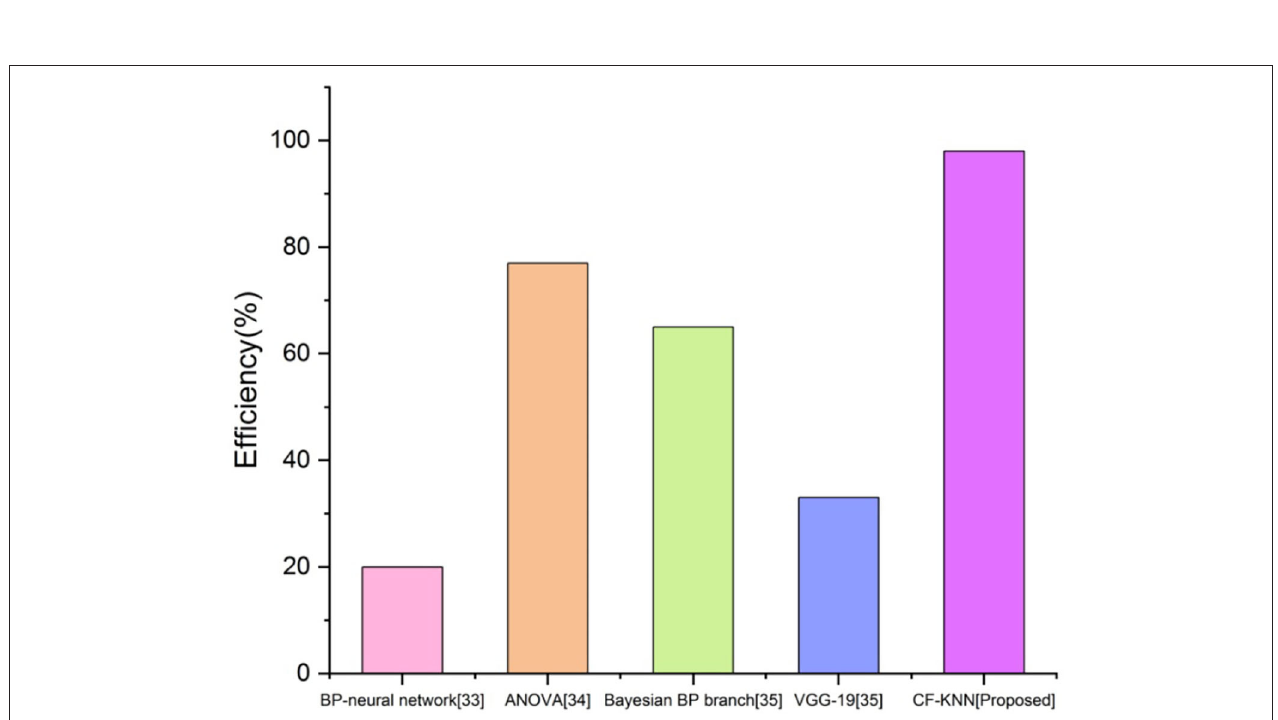
FIGURE 12 | Comparison of efficiency with proposed and existing